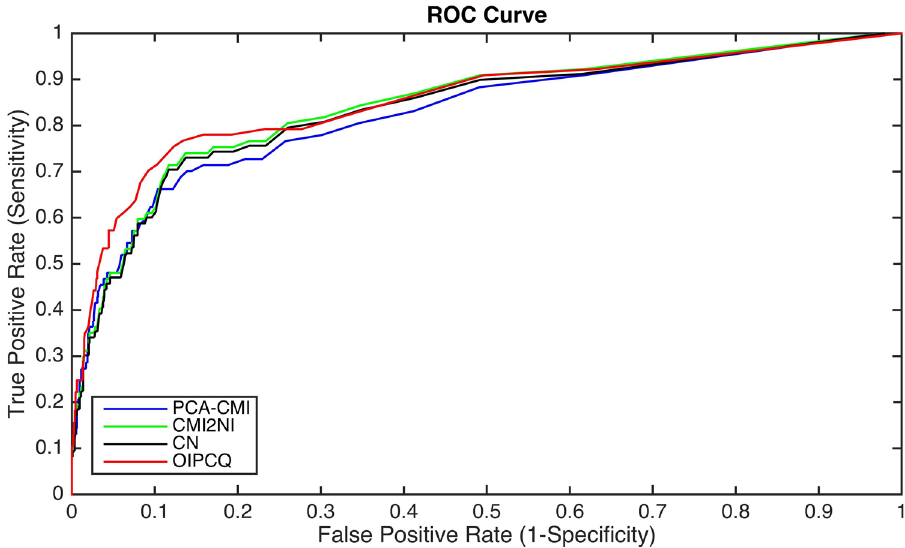
Figure 7. ROC curves of different methods for DREAM3 challenge with 50 nodes. The red line is related to the ROC curve of OIPCQ algorithm with a AUC of 0.8458 value which has a larger value than other methods.